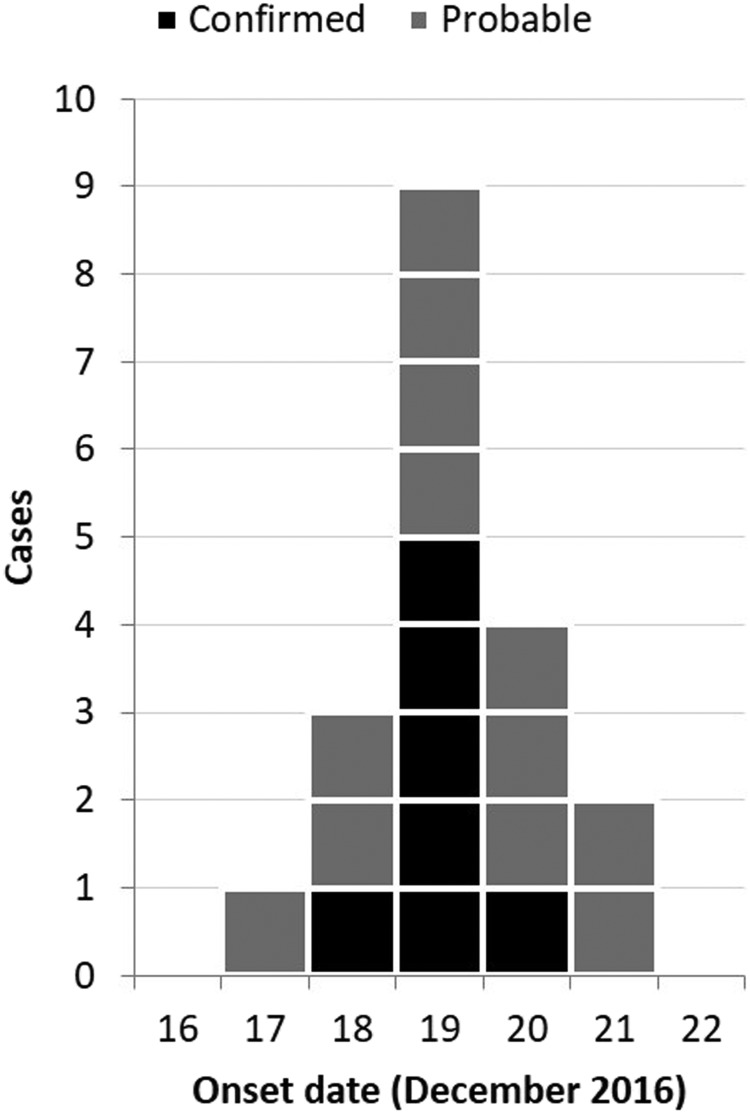
Cases of campylobacteriosis by onset date and case definition during an outbreak of campylobacteriosis at a hotel in England, December 2016 (n = 19).